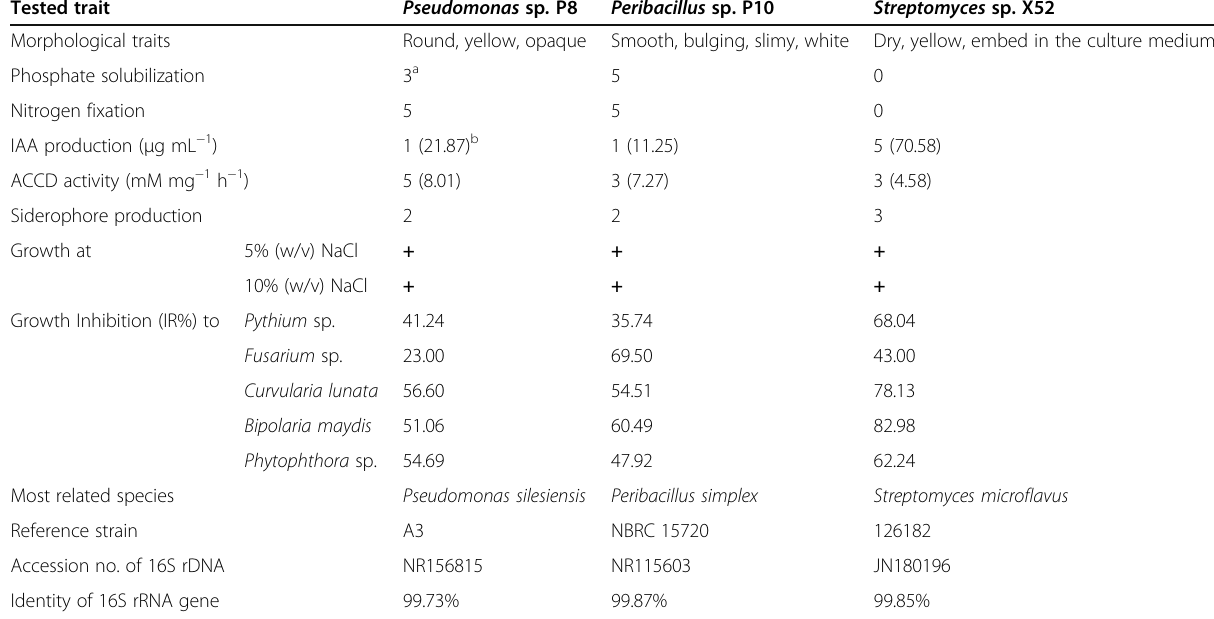
Table 1 Plant growth promoting traits and molecular identification of the selected strains in the consortium Tested